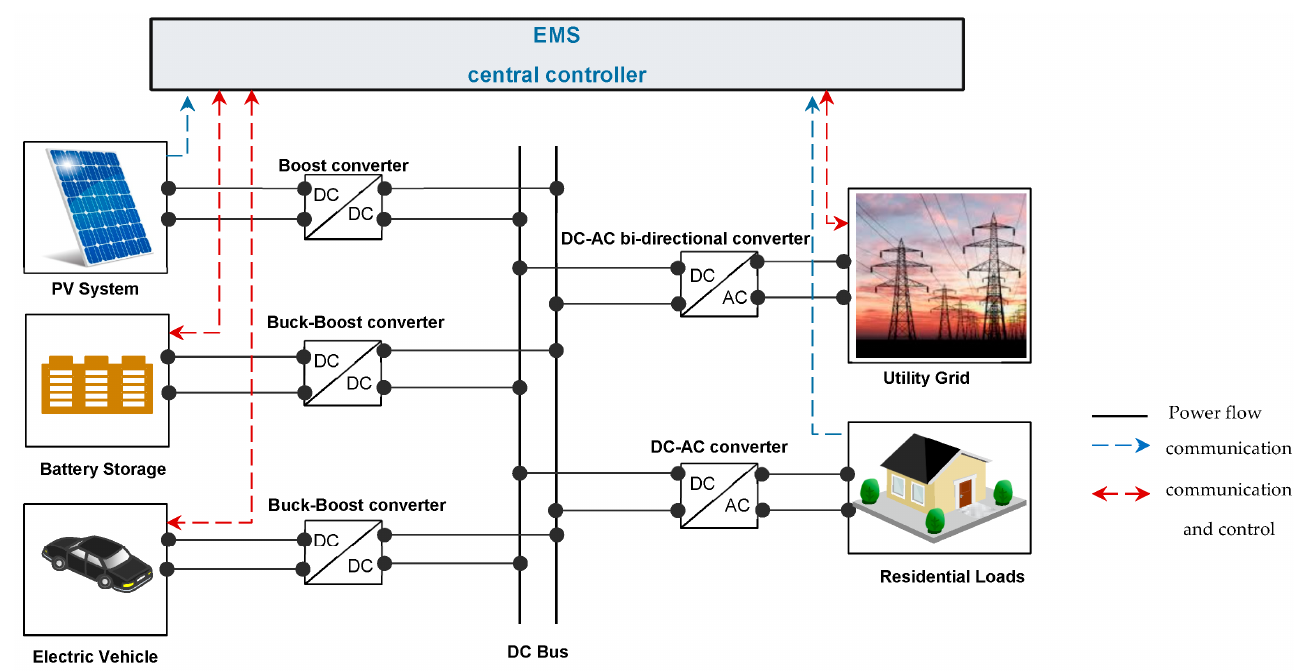
Figure 2. The con fi guration of the proposed system. Figure 2. The configuration of the proposed system.